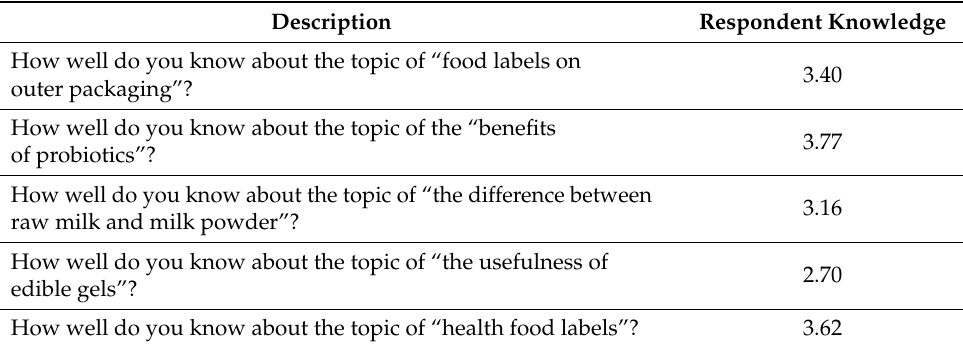
Table 5. Respondents’ knowledge of yogurt product information.